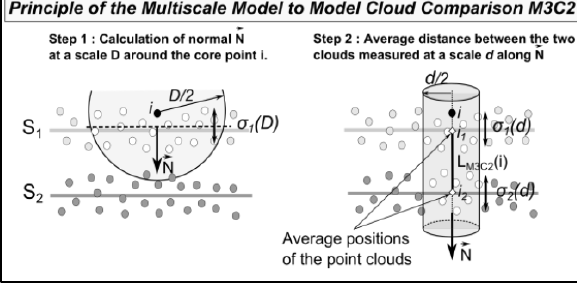
Figure 4. Description of the M3C2 algorithm and the two user- defined parameters D (normal scale) and d (projection scale) (Lague et al.,